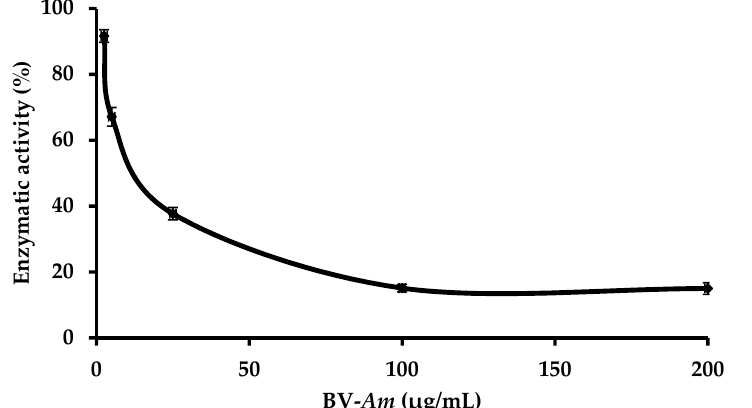
Figure 3. Curve showing the enzymatic activity (%) of the BV- Am venom on the membrane-bound E. coli F 1 F 0 -ATPase. Error bars show the standard deviation obtained from experiments done in triplicate.